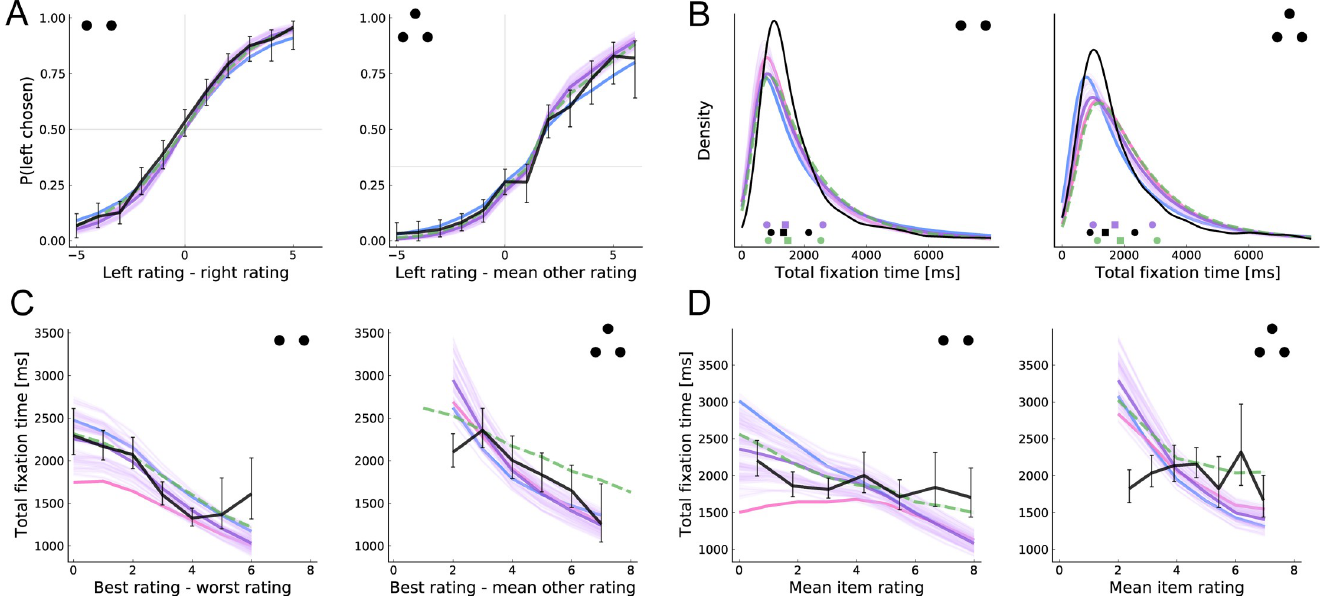
Fig 3. Basic psychometrics. Each panel compares human data (black) and model predictions for binary choice (left, two dots) and trinary choice (right, three dots). The main model predictions are shown in purple. The restricted model predictions for the case of a highly biased prior mean ( α = 0) are shown in blue; the case of a highly unbiased prior mean ( α = 1) is shown in pink. These colors were chosen to illustrate that the main model falls between these two extremes. The aDDM predictions are shown in dashed green. Error bars (human) and shaded regions (model) indicate 95% confidence intervals computed by 10,000 bootstrap samples (the model confidence intervals are often too small to be visible). Note that the method used to compute and estimate the model parameters is noisy. To provide a sense of the effect of this noise on the main model predictions, we depict the predictions of the thirty best-fitting parameter configurations. Each light purple line depicts the predictions for one of those parameters, whereas the darker purple line shows the mean prediction. In order to keep the plot legible, only the mean predictions of the biased priors models are shown. (A) Choice probability as a function of relative rating. (B) Kernel density estimation for the distribution of total fixation time. Quartiles (25%, 50%, and 75% quantiles) for the data, aDDM and main model predictions are shown at the bottom. (C) Total fixation time as a function of the relative rating of the highest rated item. (D) Total fixation time as a function of the mean of all the item ratings (overall value).